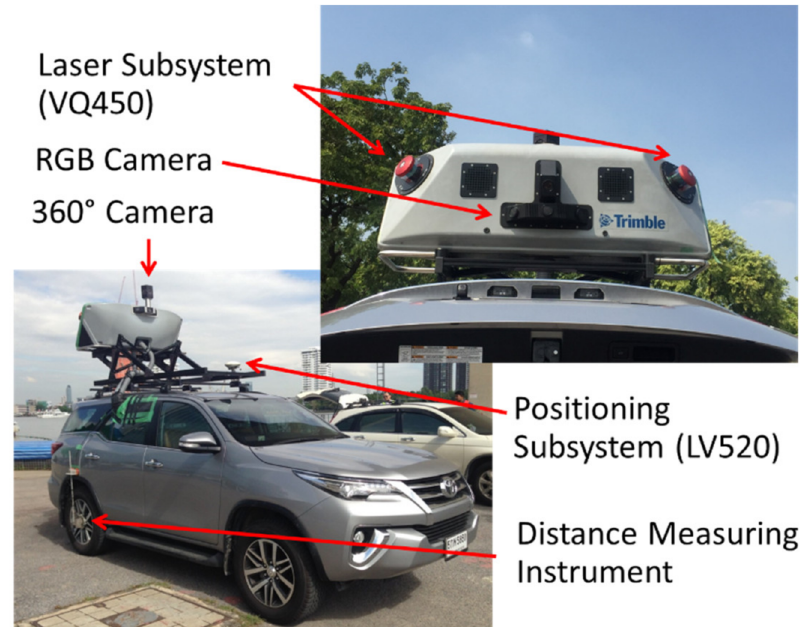
Figure 2. Details of MLS in current research work.